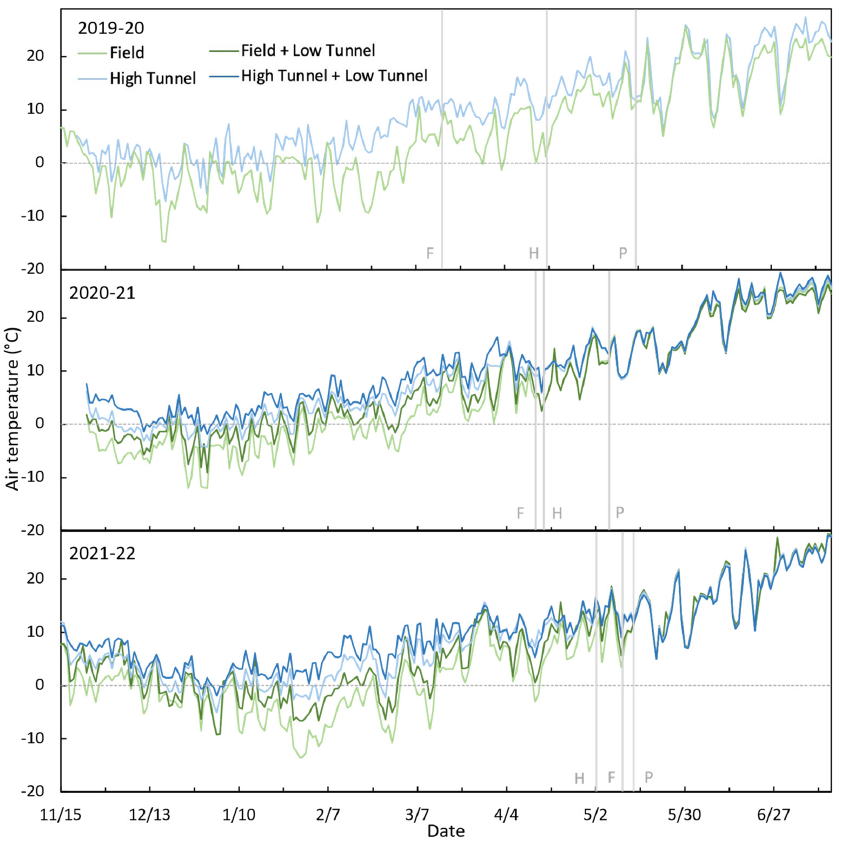
Figure 1. Average daily air temperature in 2019 − 20 ( top ), 2020 − 21 ( middle ), and 2021 − 22 ( bottom ) in an uninsulated field (light green line), a field covered with low tunnels (dark green line), a high tunnel (light blue line), and a low tunnel within a high tunnel (dark blue line) in North Logan, UT. Air temperature was measured at a 2.0 m height in 2019 − 20 [23] and 0.25 m height in 2020 − 21 and 2021 − 22. Vertical gray lines marked with F, H, and P denote the dates field low tunnels, high tunnel low tunnels, and high tunnel plastic were removed, respectively.